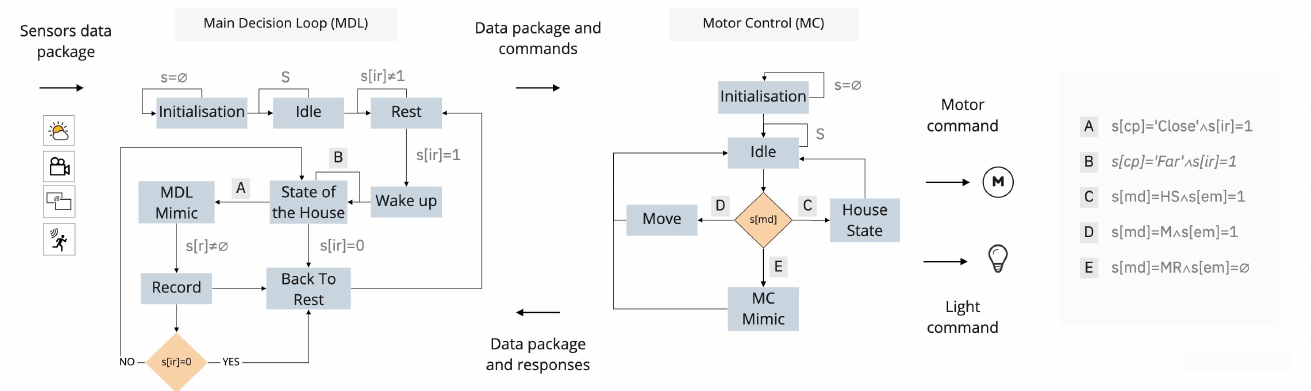
Figure 3. Finite state machines designed to command Y¯okobo’s services and